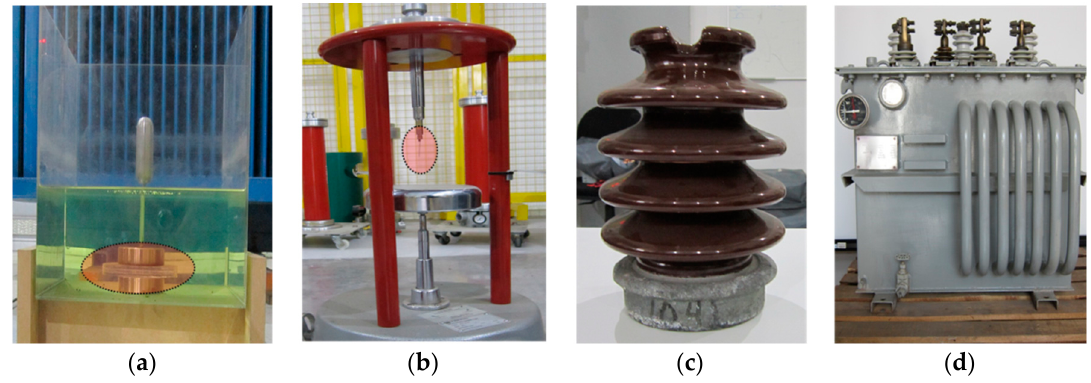
Figure 2. Test objects: ( a ) Cylindrical vacuoles; ( b ) Point-plane experimental specimen; ( c ) Figure 2. Test Contaminated ceramic bushing, and; ( d ) Power Transformers (150 kVA).